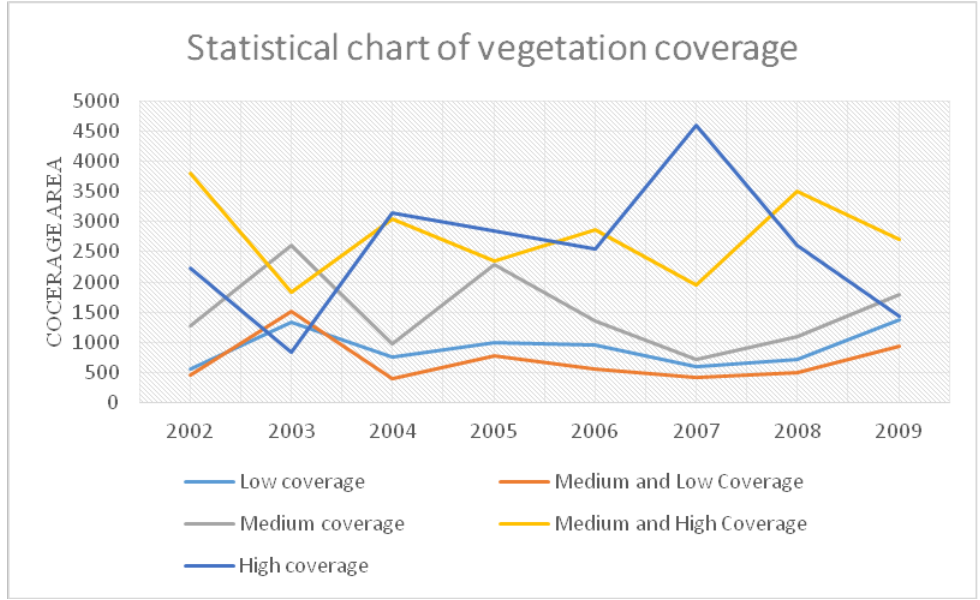
Fig. 5 Change characteristics of vegetation coverage in Wuhan from 2002 to